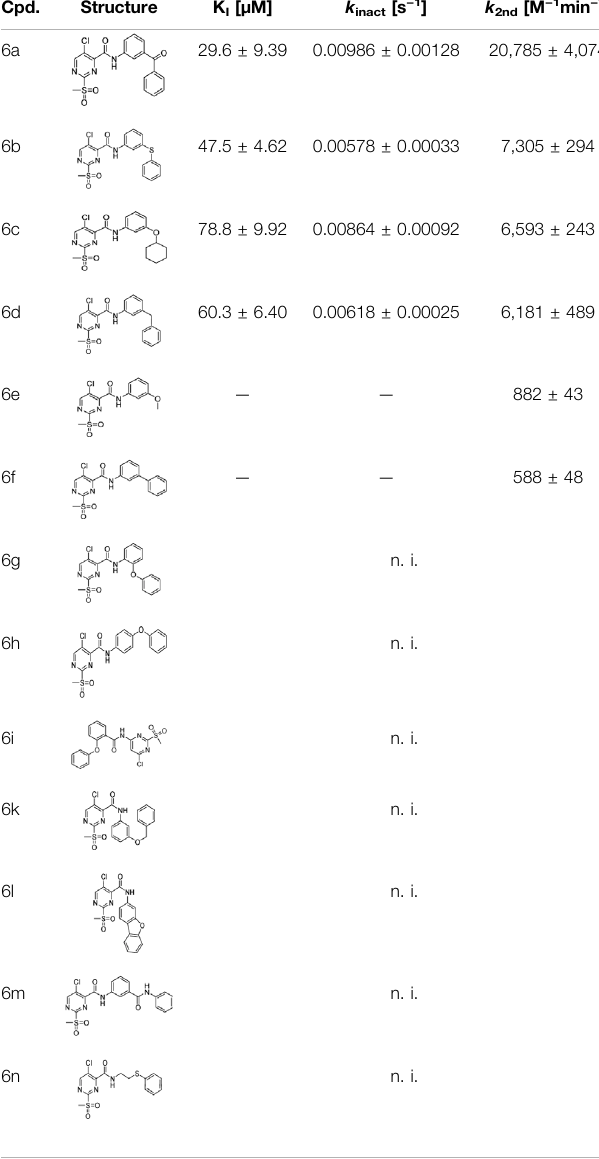
TABLE 2 | Inhibition constants (K I , k inact , k 2nd ) of the compounds 6a – n for S. aureus SrtA; n. i. (cid:1) < 20% inhibition at 100 µM.